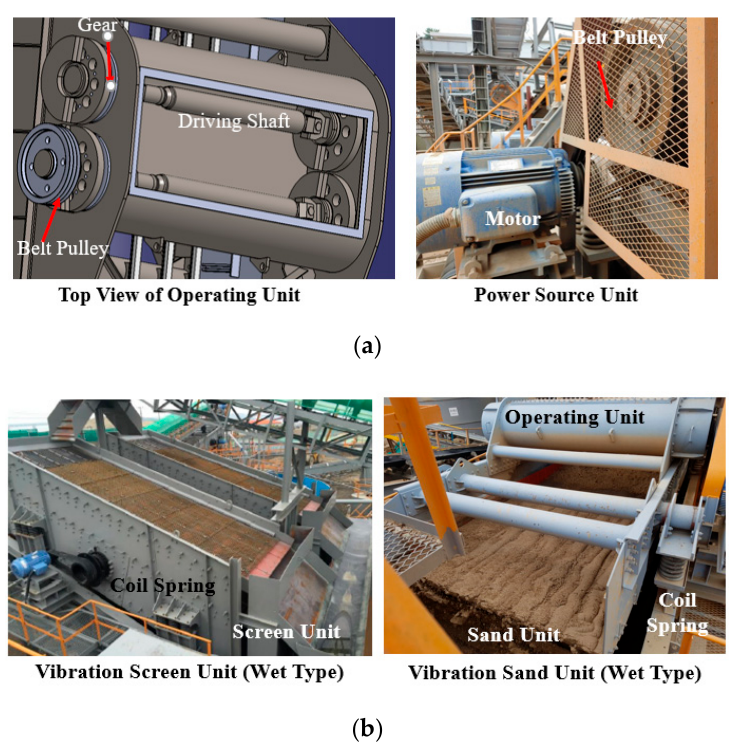
Figure 4. Vibration source of screen and sand unit and total assembly system: ( a ) Power source and power transmitted to the screen unit and sand unit: ( b ) Photograph of the screen unit and sand unit.